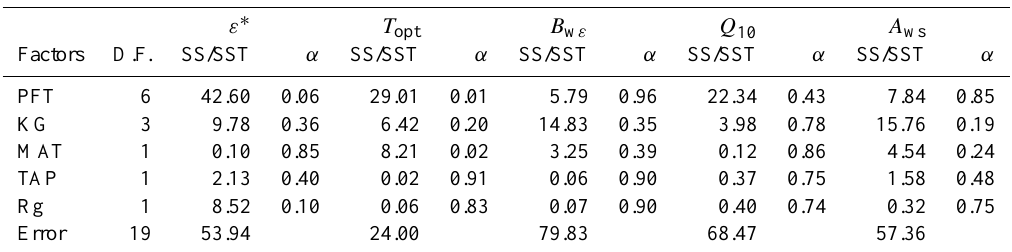
Table 4. N – way ANOVA results (%) for each optimized parameter for each factor: PFT – plant functional type; climate classification (KG) (according to Kottek et al., 2006); MAT – mean annual temperature; TAP – total annual precipitation; and Rg – incoming solar radiation. The results presented: SS – sum of squares; SST – total sum of squares; α – significance test result for each factor. The KG snow climate classes (D) were integrated within the same group and the warm temperate classes aggregated according to precipitation regimes (second letter), to avoid classes with only one site. We removed SHR from the test, since it only has one site, and grouped the climate classification in one class including all snow climates and the other classes per annual temperature and precipitation regime, to avoid having classes with one site. D.F. stands for degrees of